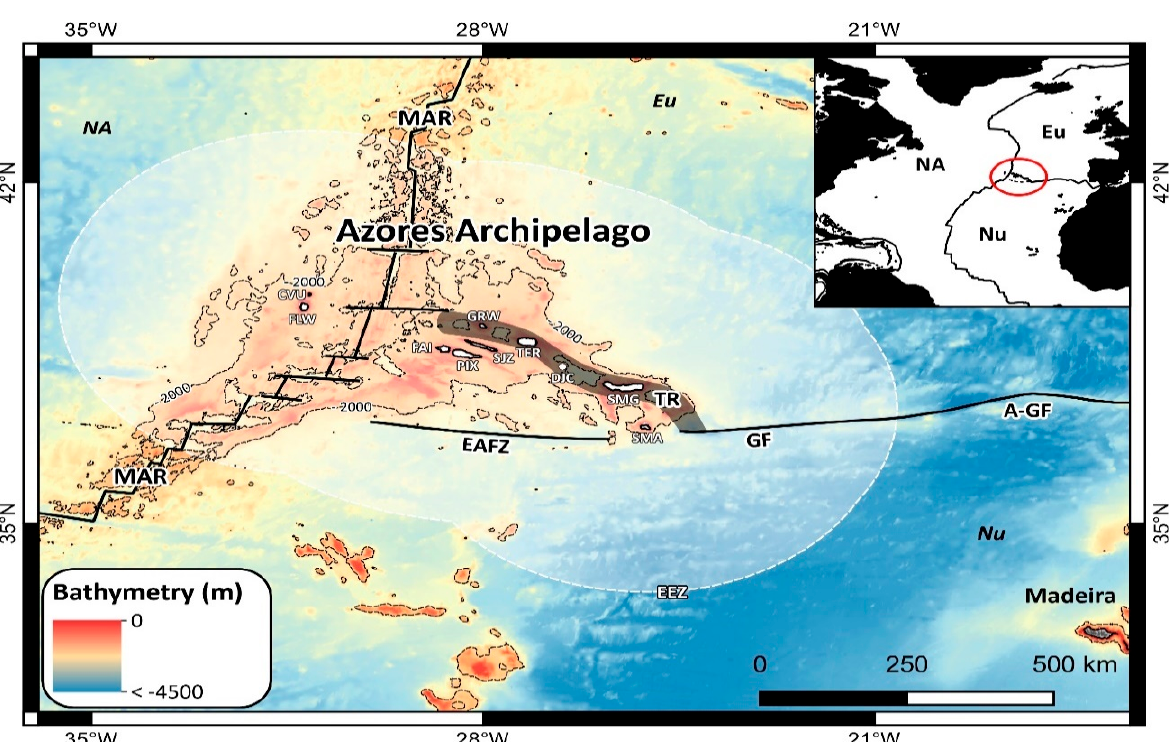
Figure 1. Geographic and geotectonic setting of the Azores Archipelago. NA: North American Plate; Eu: Eurasian Plate; Nu: Nubian Plate; MAR: Mid-Atlantic Ridge; TR: Terceira Rift; EAFZ: East Azores Fracture Zone; GF: Glória Fault; A-GF: Azores-Gibraltar Fault; SMA: Santa Maria: SMG: São